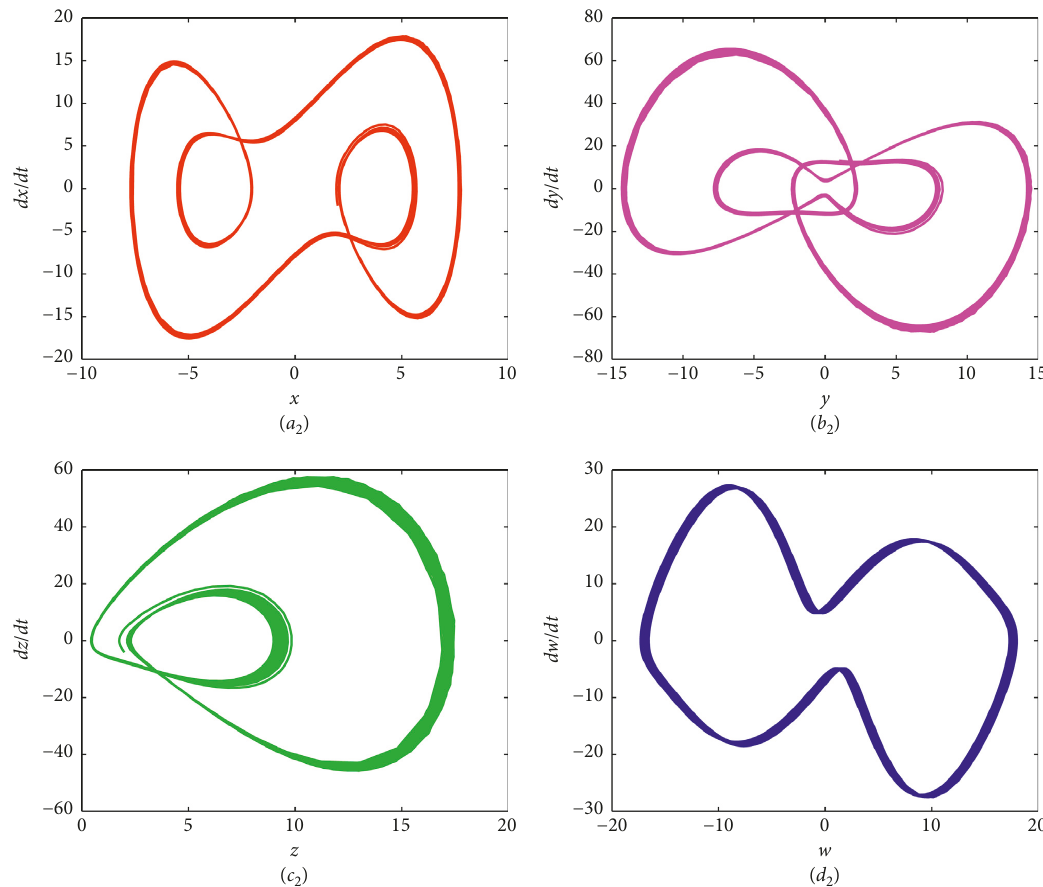
Figure 2: Phase diagrams of Experiment 1 with a � 2 , b � 1 , t � 1000: ( a ) phase diagram of w . of z ; ( d 2